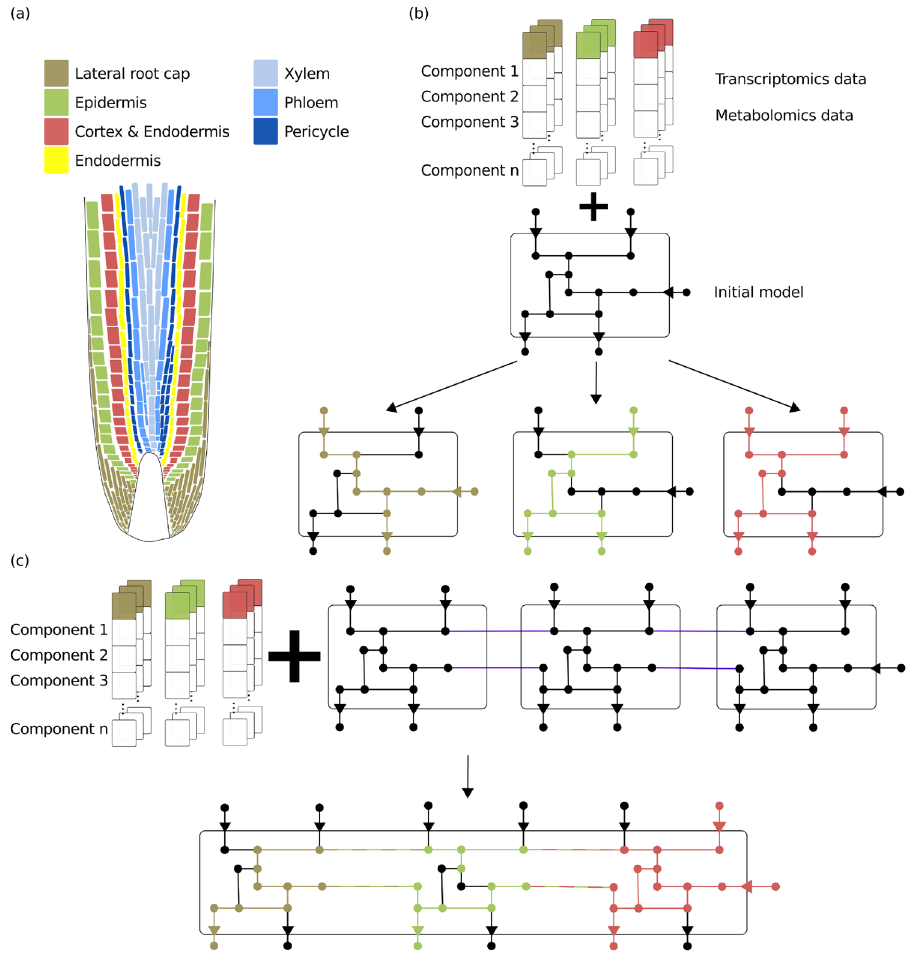
Figure 2. Cell-type specific model extraction for Arabidopsis root. ( a ) Types of tissues (stele) and cell types, i.e. epidermis, cortex, endodermis and lateral root cap. ( b ) For tissue/cell type-specific transcriptomics data, decoupled models for every single tissue are extracted from an initial generic model. Vertices represent metabolites, lines stand for reactions. Transcriptomics and metabolomics data for the components, i.e., genes and metabolites, are used for model extraction. Colored lines correspond to reactions that are extracted from the initial model. The colors correspond to the respective tissue. ( c ) The replicates of the initial model are connected to each other via exchange reactions. A multi-tissue model is then extracted based on the corresponding transcriptomics data. The purple colored lines show the reactions connecting the multi- tissue model. The single-tissue specific parts within the multi-tissue model refer the coupled models, and are represented in different colors. Note that the decoupled and coupled models may